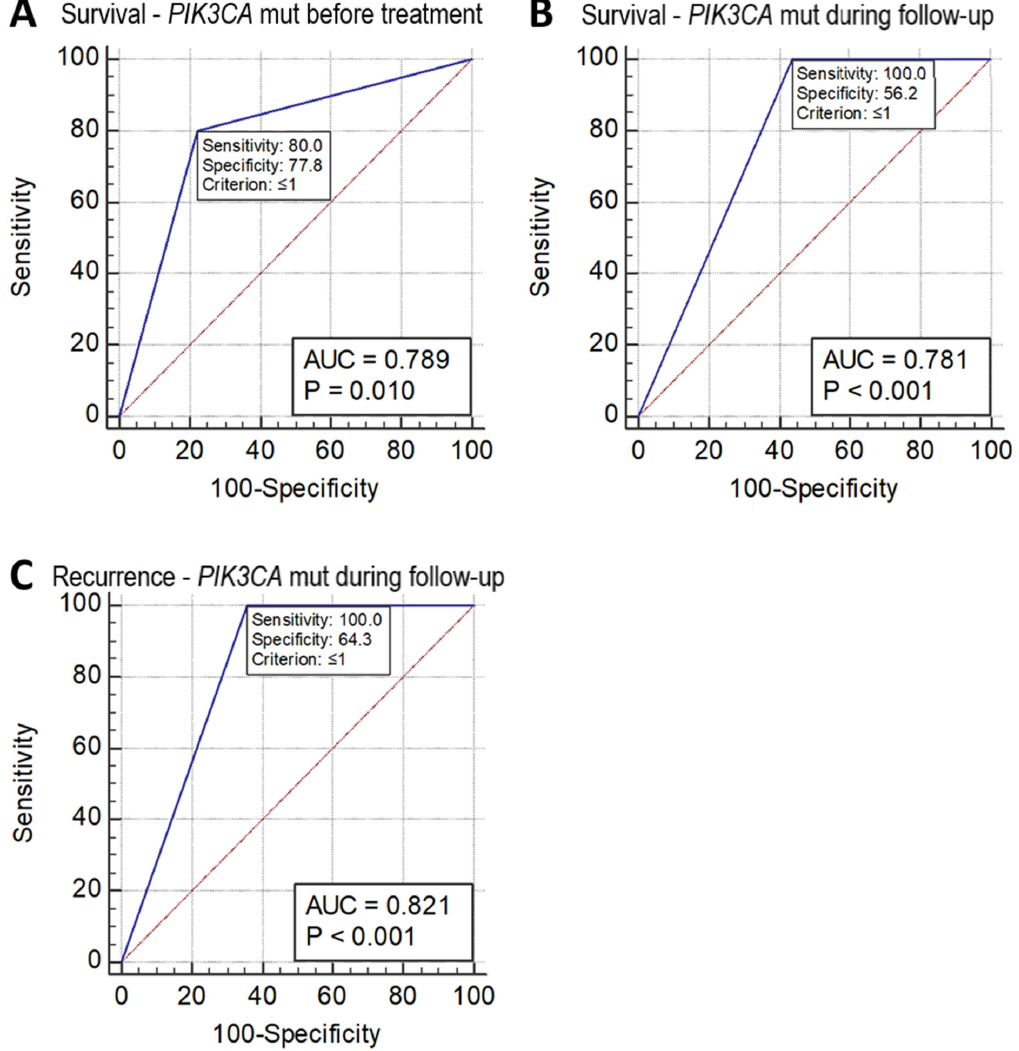
Figure 2. ROC chart. ( A ) Survival of cervical adenocarcinoma predicted by PIK3CA mutation status as detected in circulating DNA collected before treatment. ( B ) Survival of cervical adenocarcinoma predicted by PIK3CA mutation status as detected in circulating DNA collected during follow-up after treatment. ( C ) Recurrence of cervical adenocarcinoma predicted by PIK3CA mutation status as detected in circulating DNA collected during follow-up after